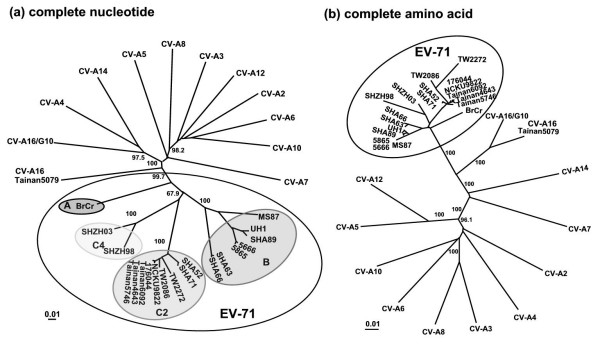
Phylogenetic relationships amongst HEV-A isolates. The neighbour-joining tree was established from alignments of the full genome nucleotide (a) and amino acid sequences (b). The percentage of bootstrap replicates supporting the trees are indicated at the nodes. The branch lengths are proportional to the genetic distances corrected using Kimura-two-parameter substitution model.